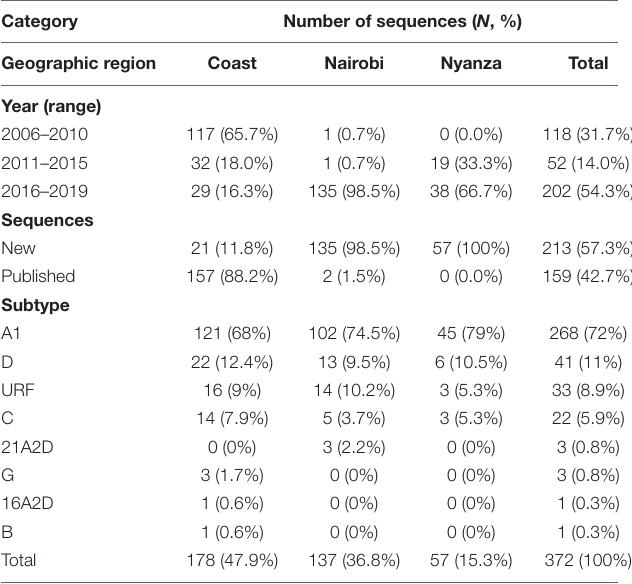
TABLE 1 | Distribution of newly generated and published HIV-1 pol sequences ( N = 372) from Kenyan MSM, overall, and by geographic location. Category Number of sequences ( N , %)